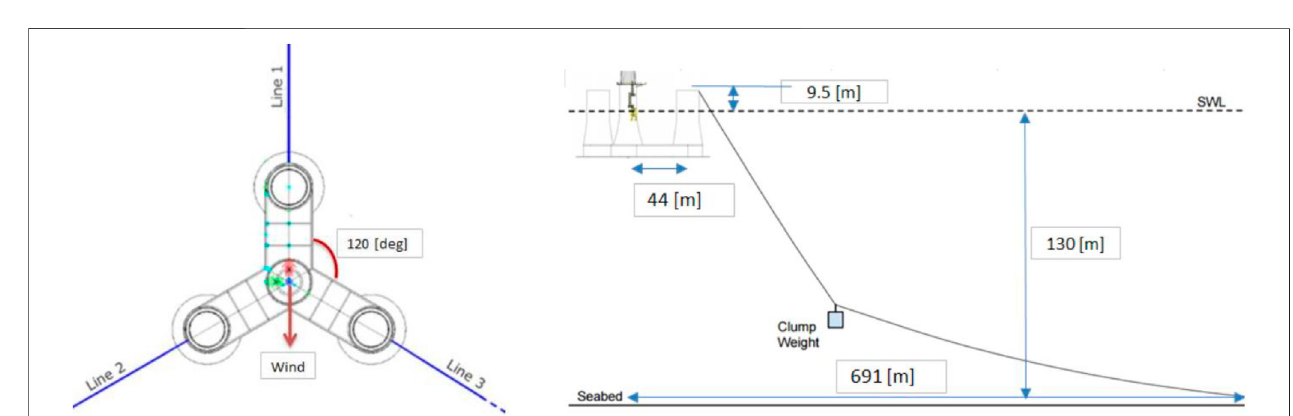
FIGURE 3 | Sketch of the mooring system in the 10-MW FWT (left: top view; right: side view).